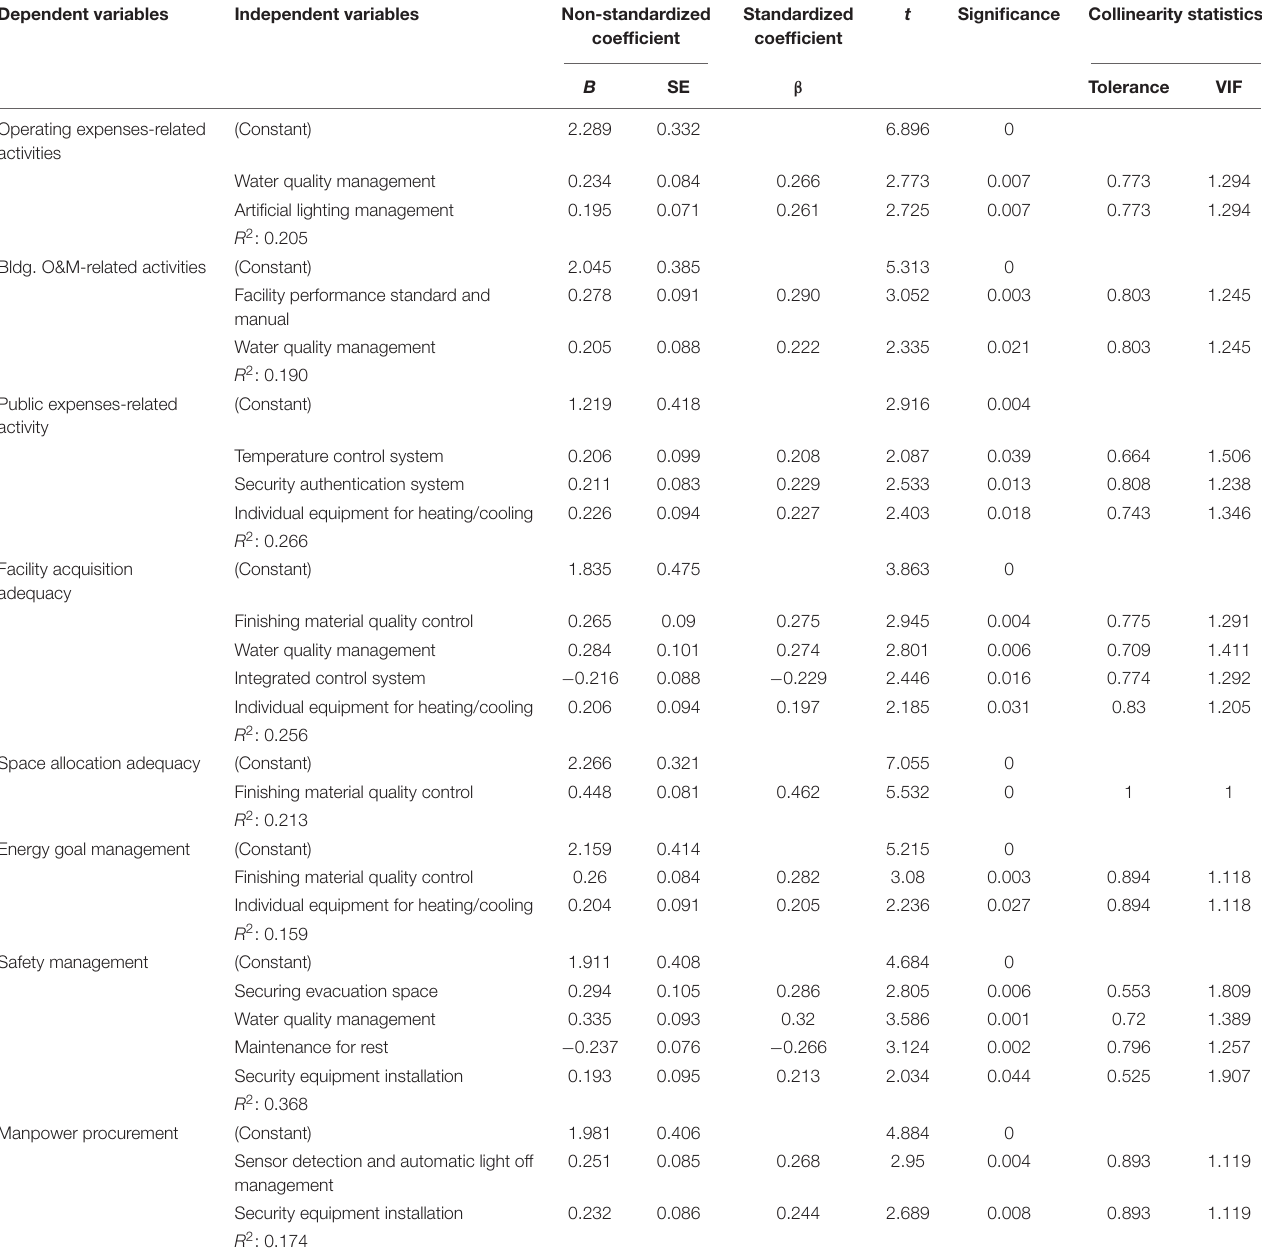
TABLE 4 | Multi-linear regression of UFM items for UFM